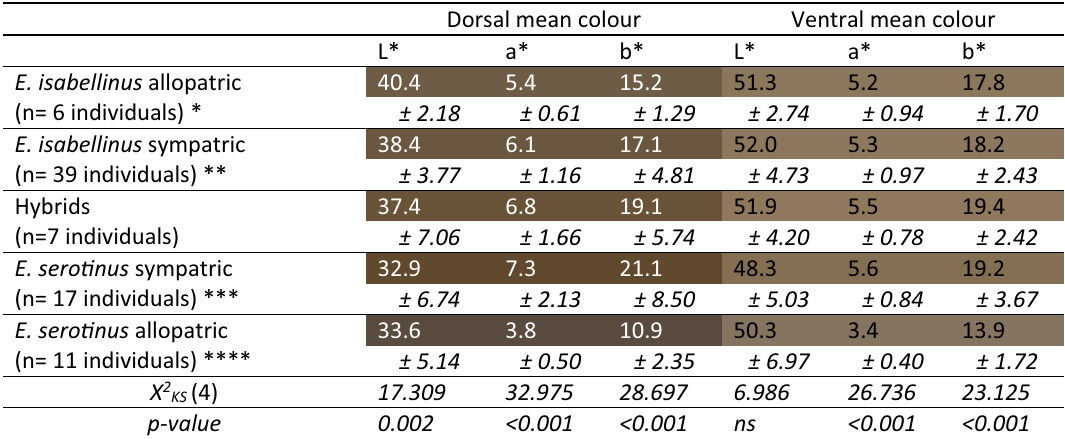
Table 2. Descriptive statistics of the dorsal and ventral colour of E. serotinus , E. isabellinus and their hybrids. Background colour represents the mean colour of the dorsum and belly in the CIELAB colour space of each parental species in function to their different geographical relationships and their